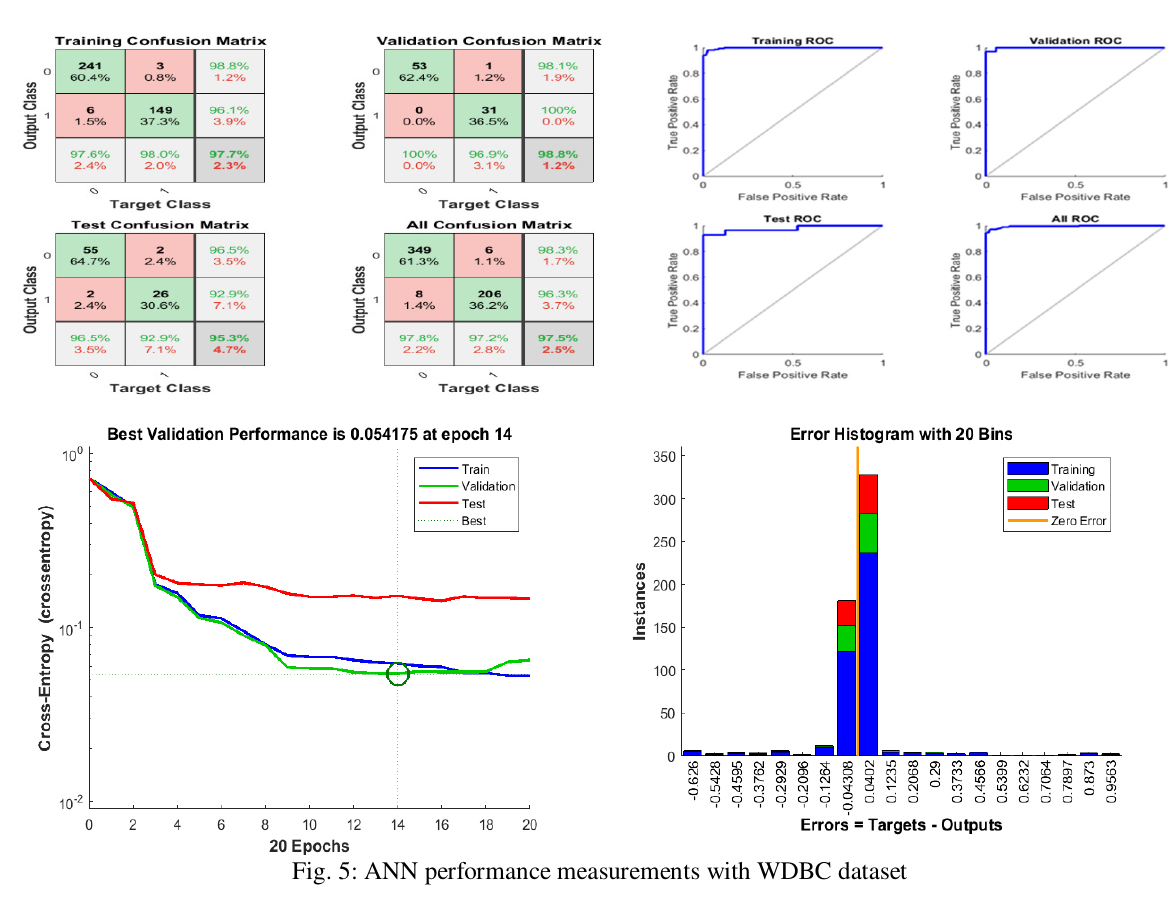
Fig. 5: ANN performance measurements with WDBC dataset